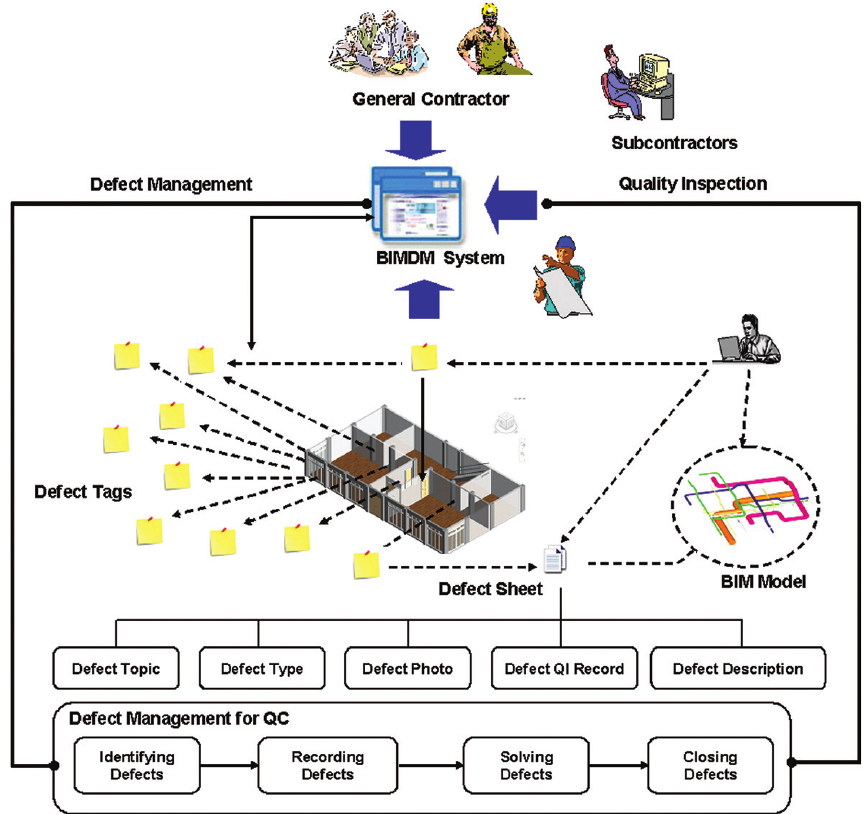
Fig. 1. Applications of BIM technologies for defect management in